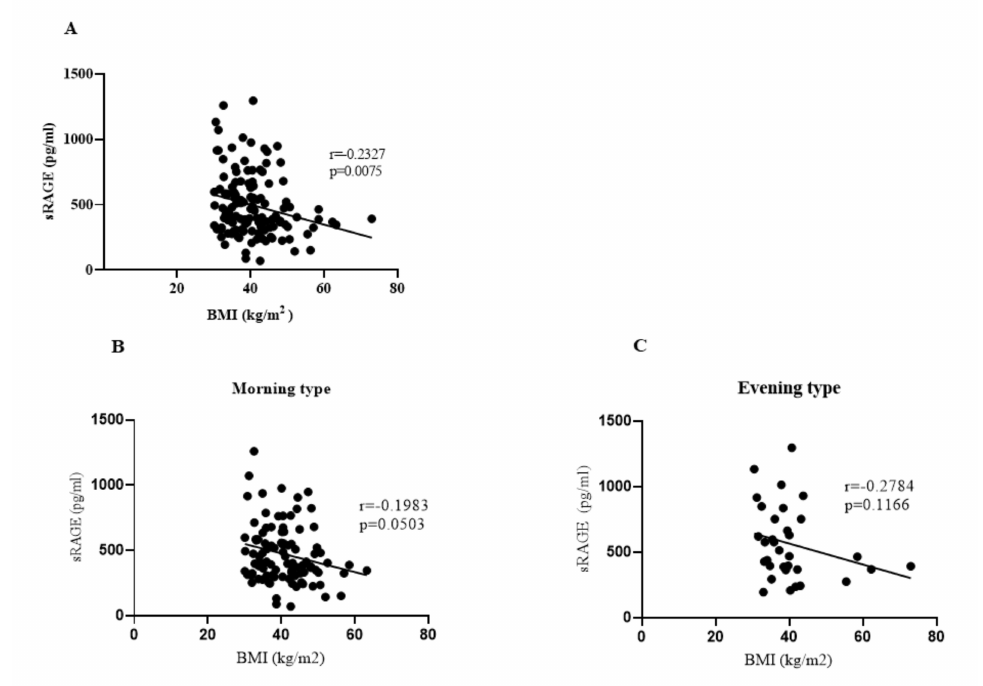
Figure 3. Correlation between serum sRAGE concentration (pg/mL) and BMI (kg/m 2 ) before caloric restriction; Spearman test. ( A ) In the study group, n = 131. ( B , C ) In each chronotype: ( B )—morning type ( n = 98), ( C )—evening type ( n =